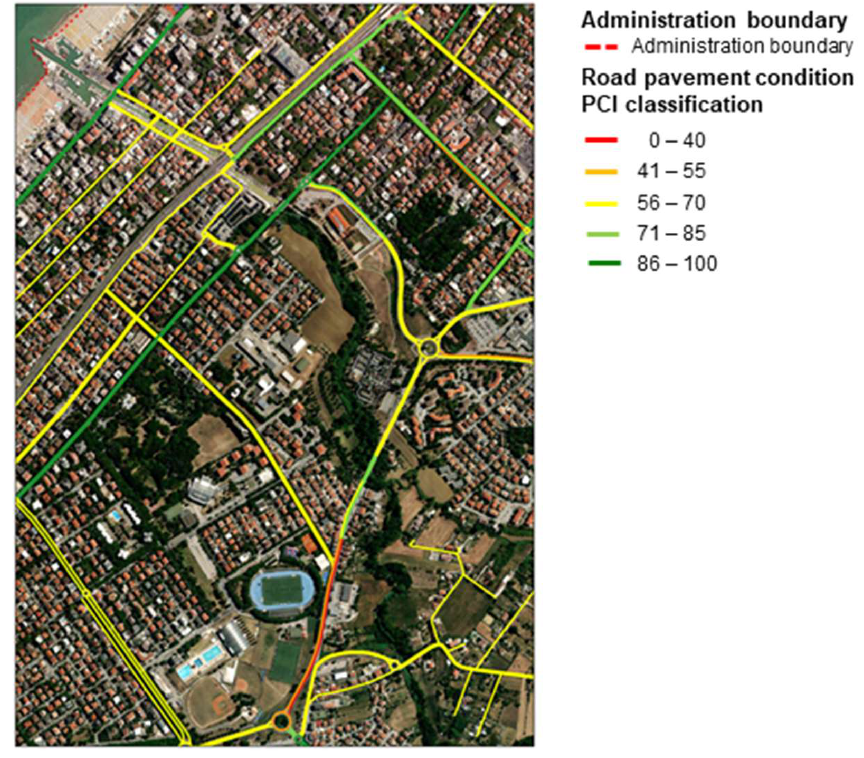
Figure 5. Example of GIS mapping of the road pavement condition (PCI classification).